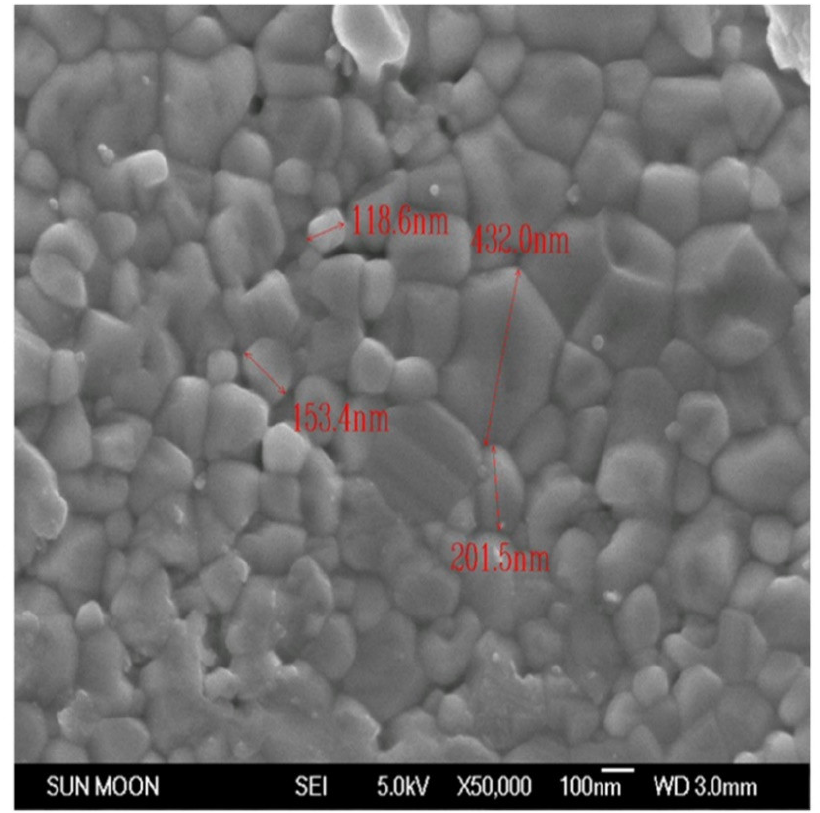
Figure 3. FESEM image of BiFeO 3 .